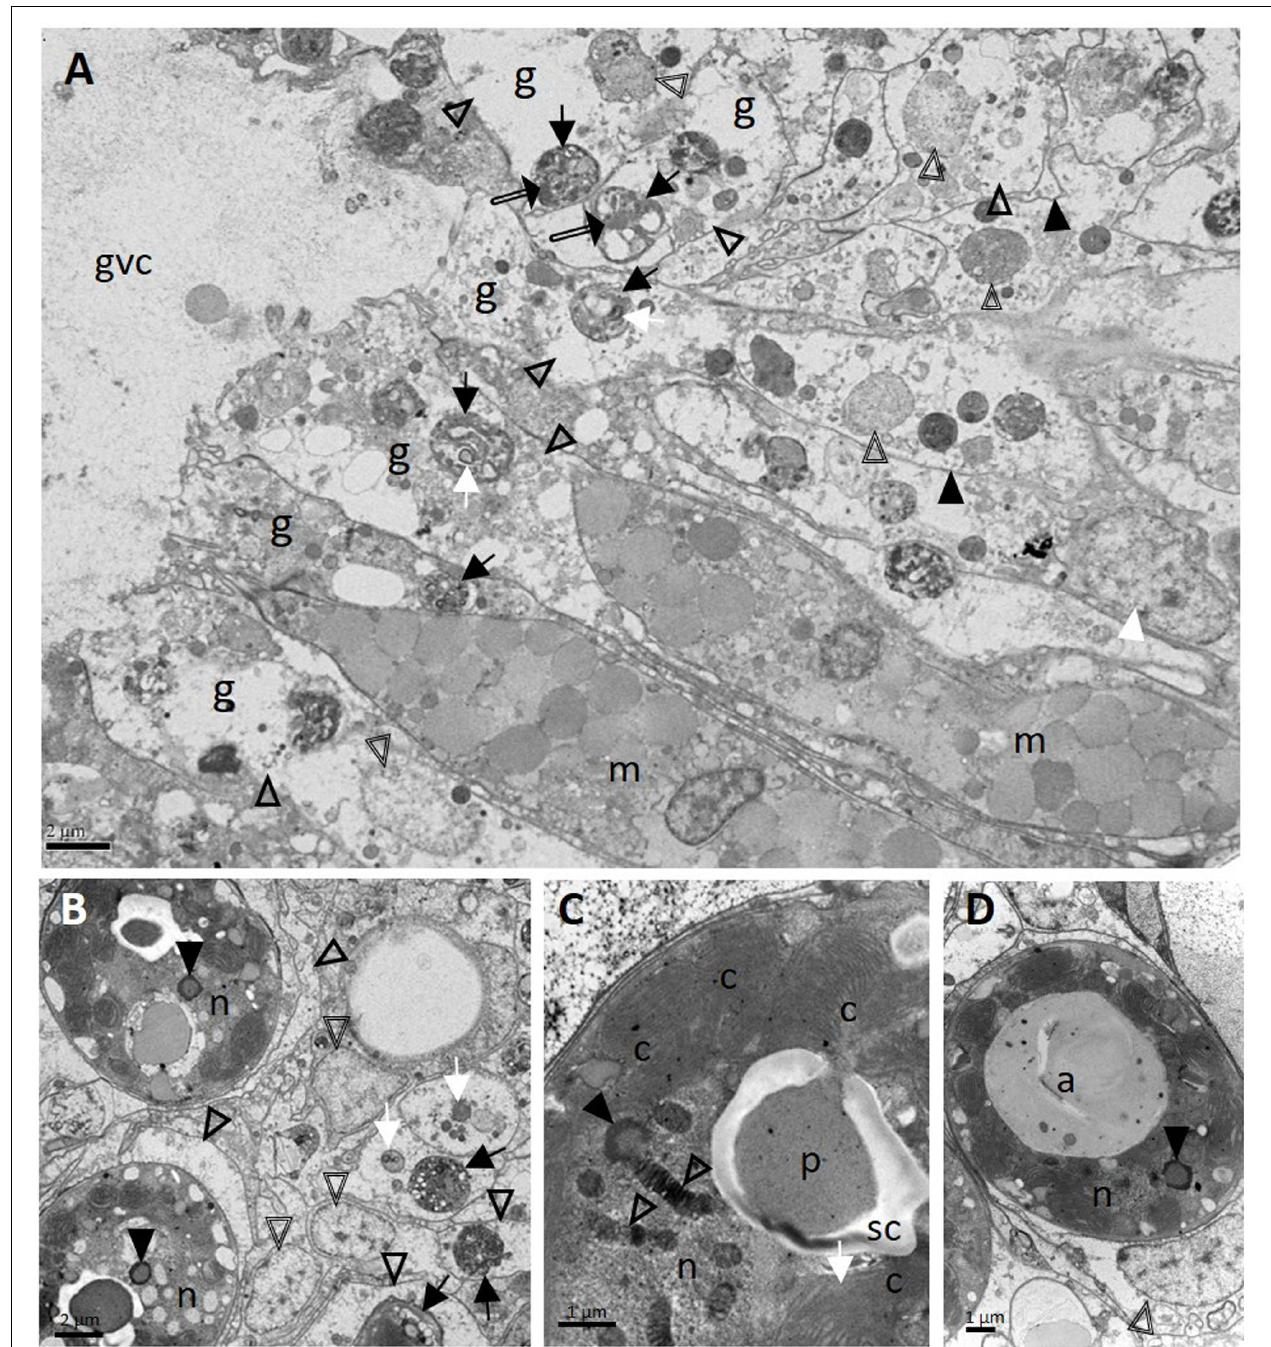
FIGURE 8 | Ultrastructure of Montastraea cavernosa surface body wall gastrodermis showing pathology of coral host cells and zooxanthellae. (A) Note intact mucocytes adjacent to gastrodermal cells manifesting marked vacuolation with intact cell membranes (closed arrowheads), an intact nucleus (white arrowhead), or degrading nuclei (double-line arrowheads) leading to loss of tissue architecture. Note zooxanthellae ex hospite (arrows) manifesting varying stages of intracytoplasmic vacuolation, some with shrunken pyrenoids (white arrows), dilated symbiosomes with debris (open arrowheads), and different-size clumps of variably electron-dense material (possible lipid) (double-line arrows). (B) Zooxanthellae showing degrading nuclei with peripheral chromatin (closed arrowheads), enlarged vacuolar matrices (open arrowheads) filled with debris (white arrows) and at different states of shrinkage (black arrows). Double-line arrowheads point to host-cell nuclei. (C) Zooxanthella showing degrading chromatin in permanently condensed chromosomes of nucleus (open arrowheads), formation of condensed peripheral chromatin (closed arrowhead), and a degenerating chloroplast with loss of thylakoid lamellar structure (white arrow). (D) Degenerating zooxanthella showing an enlarged accumulation body and nucleus with an area of degrading peripheral chromatin (arrowhead). Note host-cell nucleus (double-line arrowhead) still intact. a, accumulation body; c, chloroplasts; g, gastrodermal cell; gvc, gastrovascular canal; m, mucocytes; n, nucleus; p, pyrenoid; sc, starch cap.